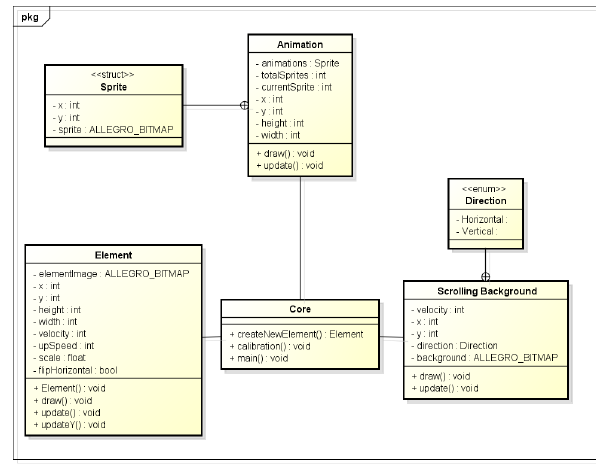
Fig. 2: The Handcopter Game classes.